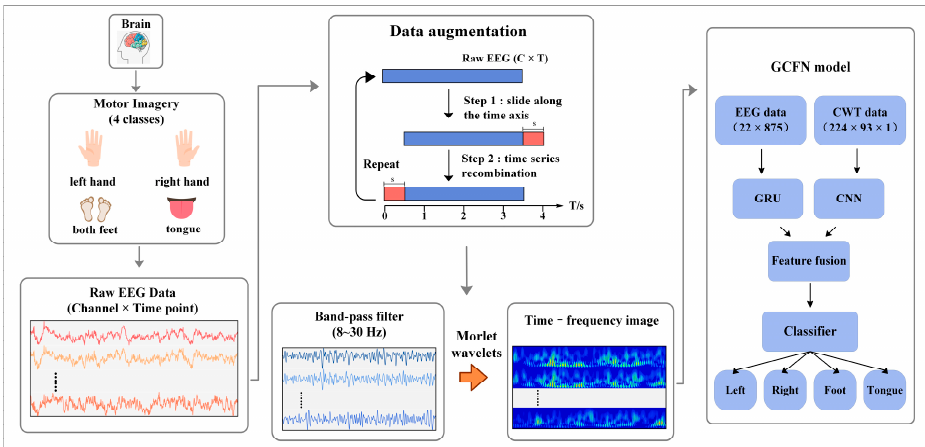
Figure 1. The system architecture of the proposed method, including EEG acquisition, data augmentation, preprocessing and feature extraction, and a deep learning model.